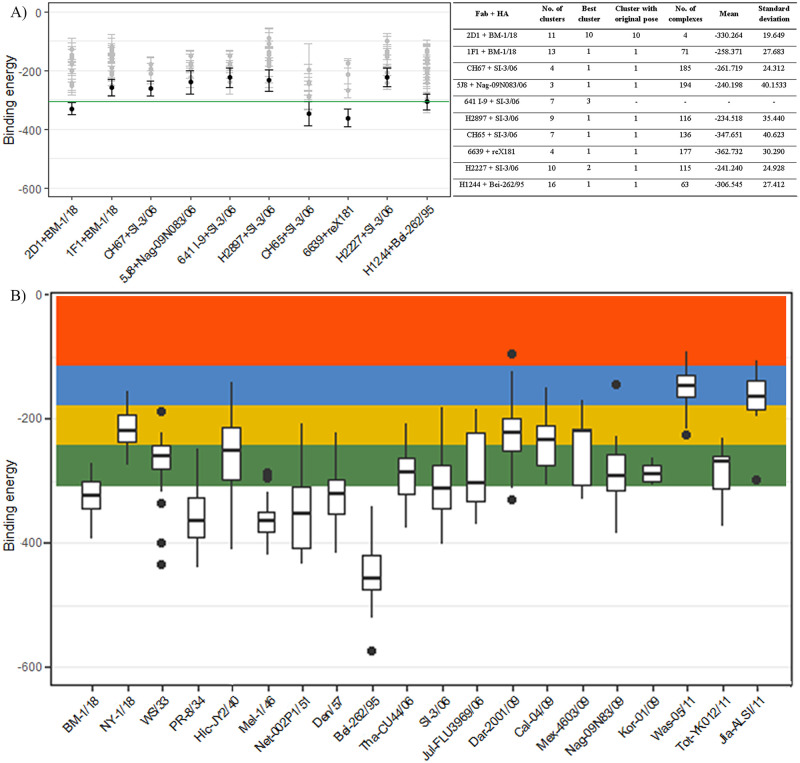
The binding energy between Fab and HA protein of different strains of H1N1 influenza A virus.(A) The binding energy of different Fab templates on their corresponding HA was calculated by the HADDOCK tool. The best cluster of each case was expressed as black, while other clusters showed in gray, mean value of all complexes in original clusters was colored in green. Data were shown in the mean and standard deviation bars. (B) The binding energy of the proposed Fab model at RBS of HA protein of different H1N1 influenza A virus strains were shown as boxplot comparing with templates. The shaded error of binding energy of templated was indicated by colors: Green = mean and 1s.d., yellow = 2s.d., blue = 3s.d., and red > 3s.d. The clustering of results was done by the HADDOCK tool based on interface Root-mean-square deviation (RMSD) and Fraction of common contacts (FCC).